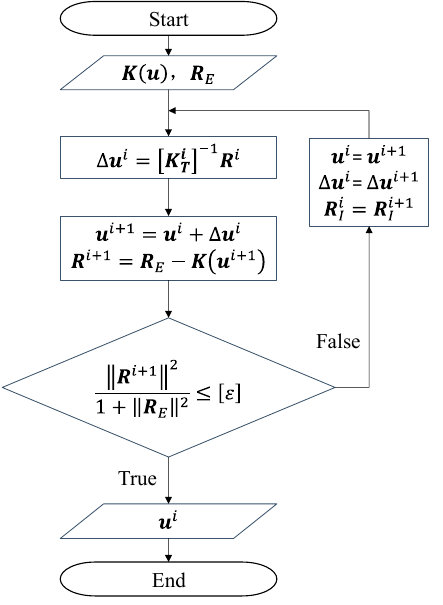
Figure 1. The process of solving the blade stiffness using the Newton–Raphson iteration method.